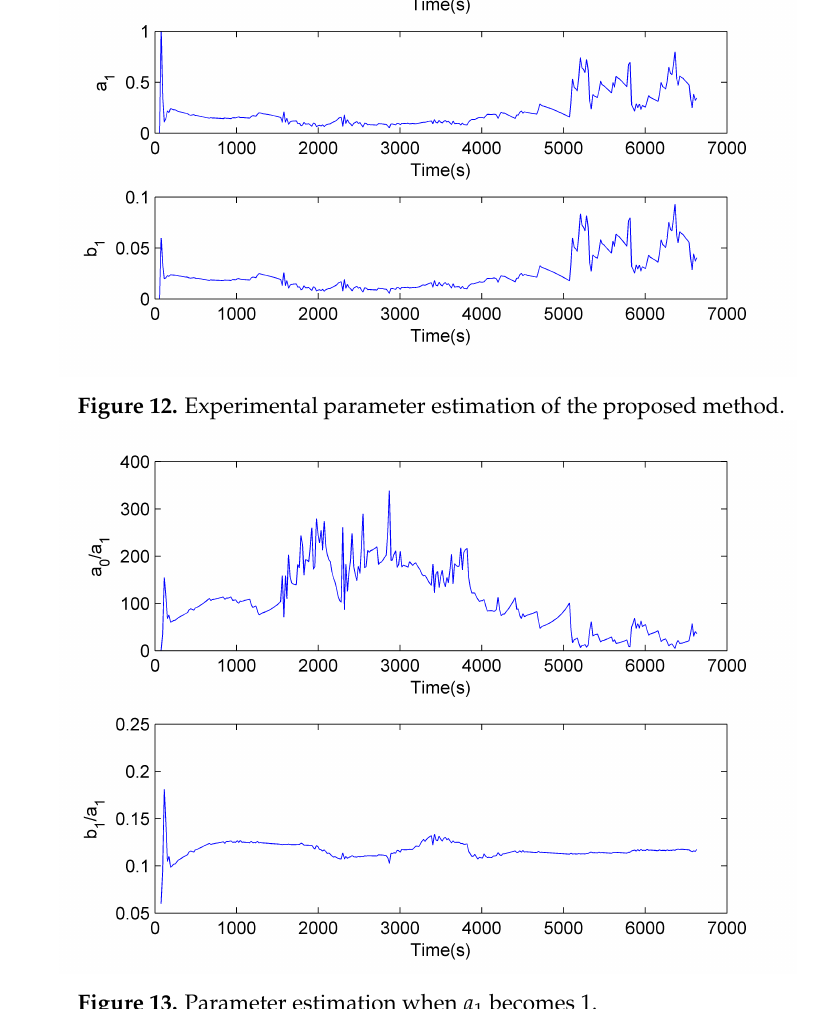
Figure 13. Parameter estimation when a 1 becomes